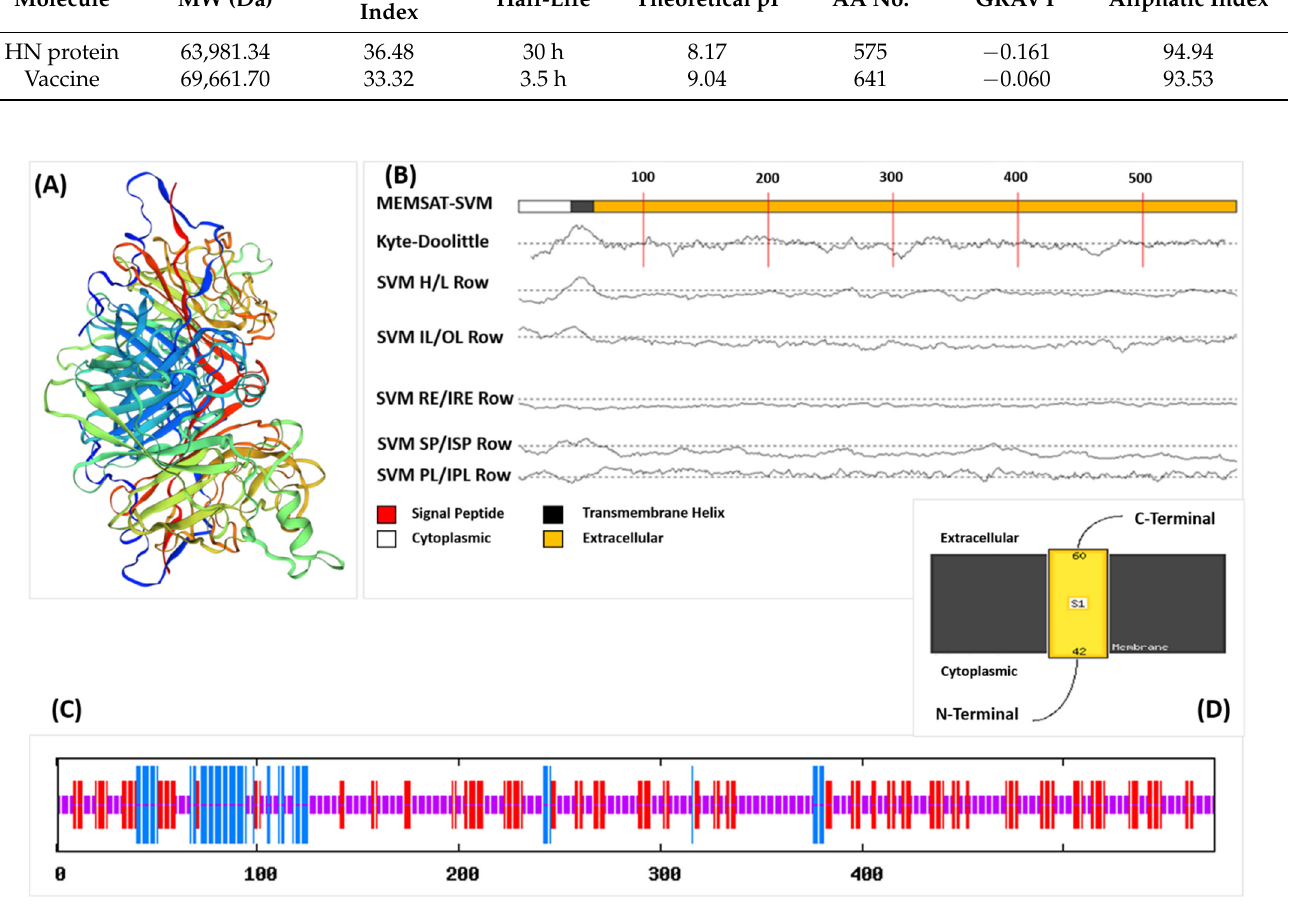
Table 1. Physiochemical properties of HN protein and vaccine predicted by ProtParam.